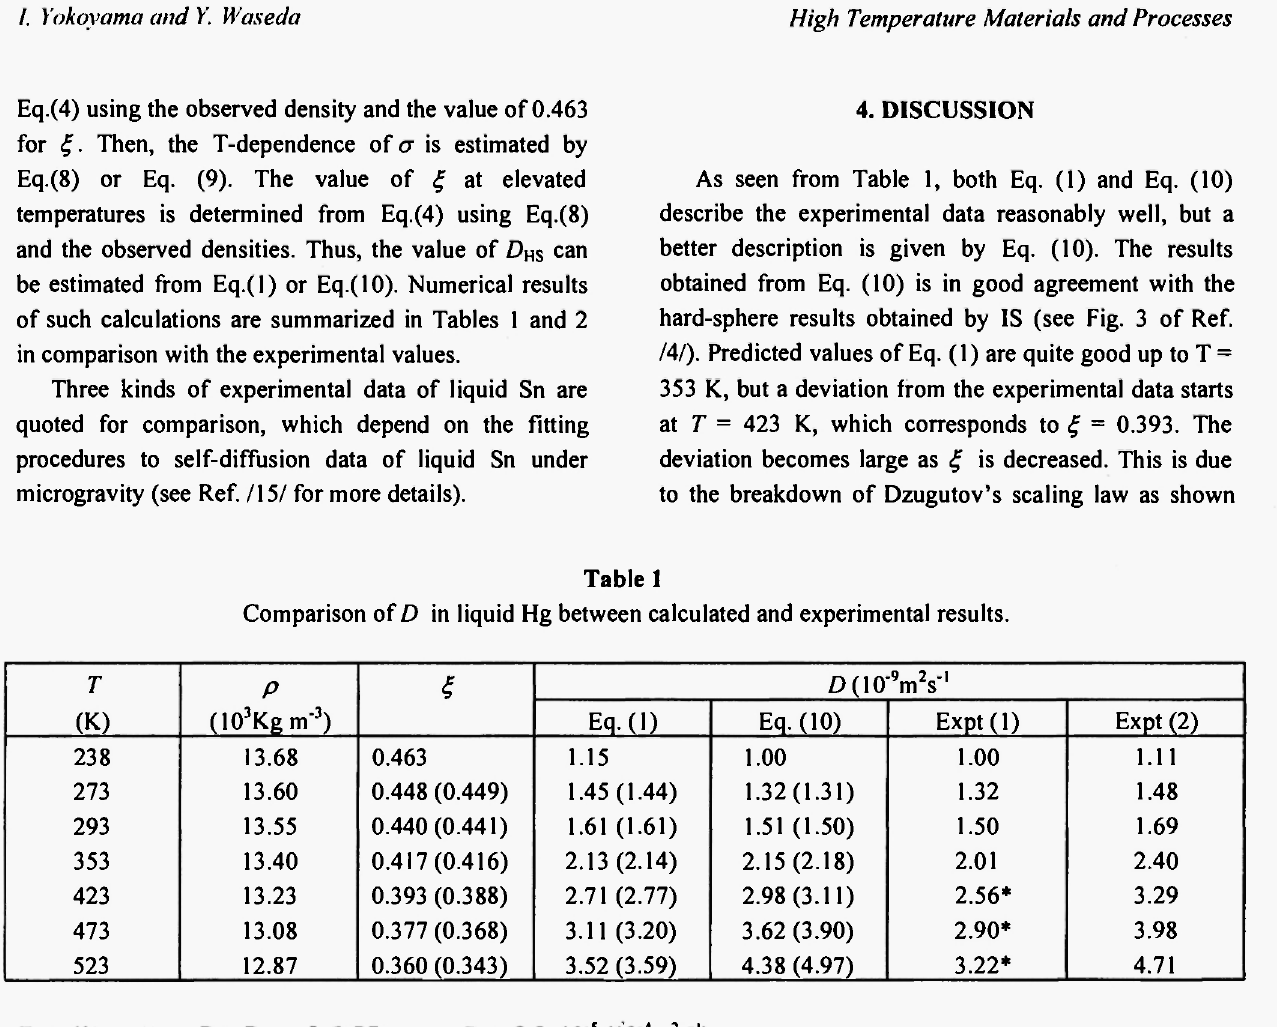
Comparison of D in liquid Sn between calculated and experimental